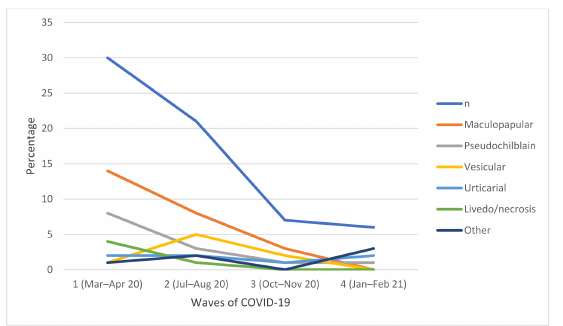
Figure 1. Evolution of the incidence of cutaneous lesions associated with COVID-19 over the 4 waves of the